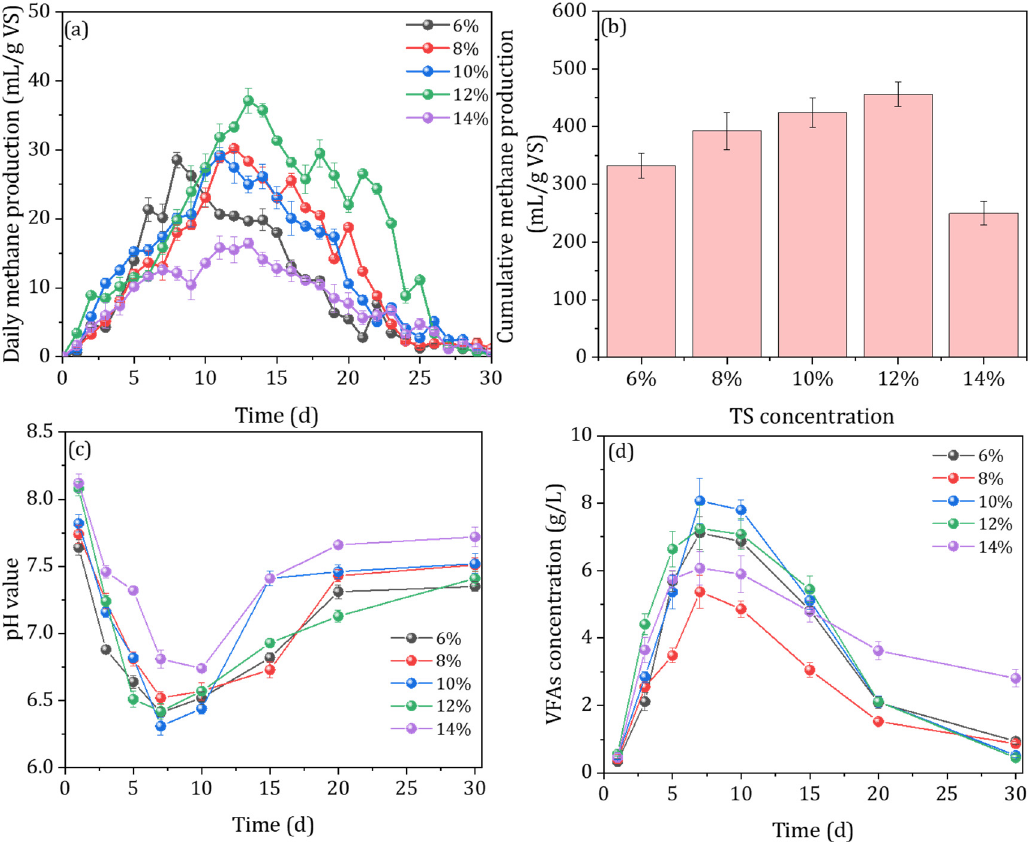
Figure 3. The daily methane production ( a ), cumulative methane production ( b ), the evolution of pH value ( c ), and VFA concentration ( d ) under different TS concentrations, 1:5 mixing ratio, and 15% inoculum amount.